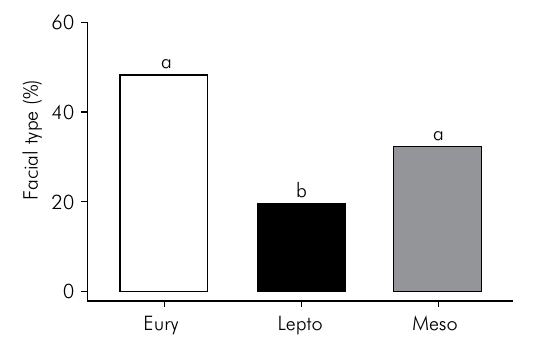
Figure 4. Distribution among facial types. Different lowercase letters show a statistical difference between facial types (p = 0.032).